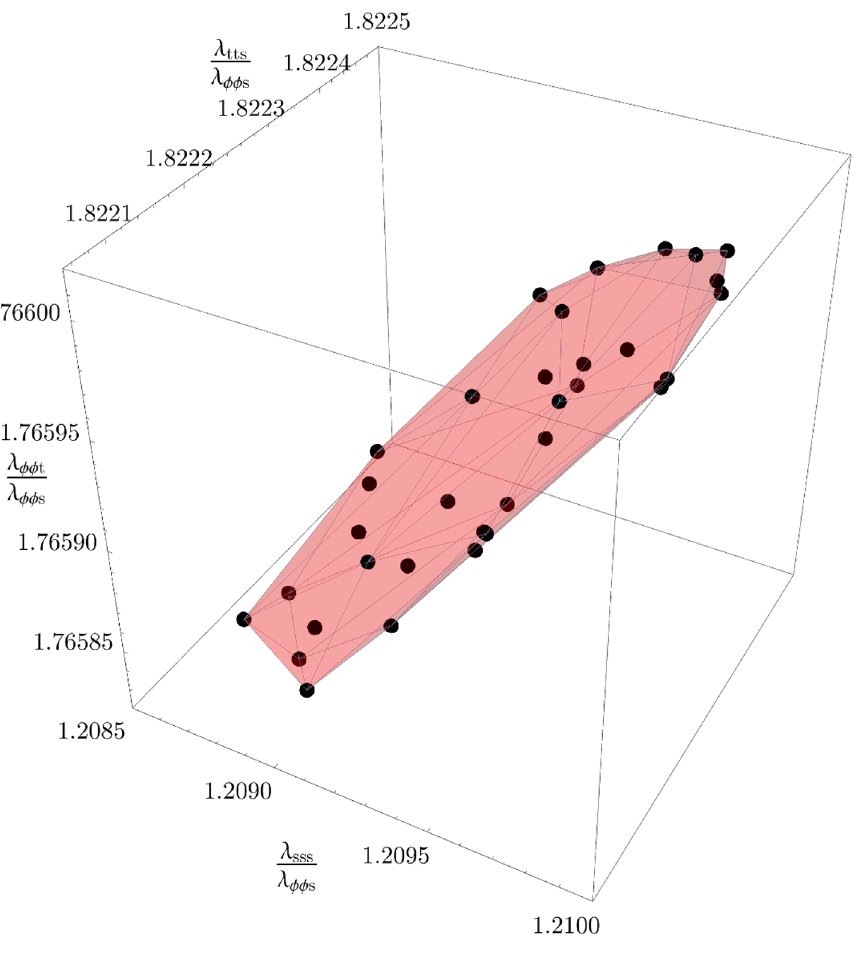
Figure 12 . Allowed points in the space of OPE coe(cid:14)cient ratios computed using the f (cid:30) i ; s; t ij g system at (cid:3) = 43. The convex hull of these points (red) gives an estimate for the allowed values of these coe(cid:14)cients. The projection of the full 6d allowed region will be slightly larger so the shown region is